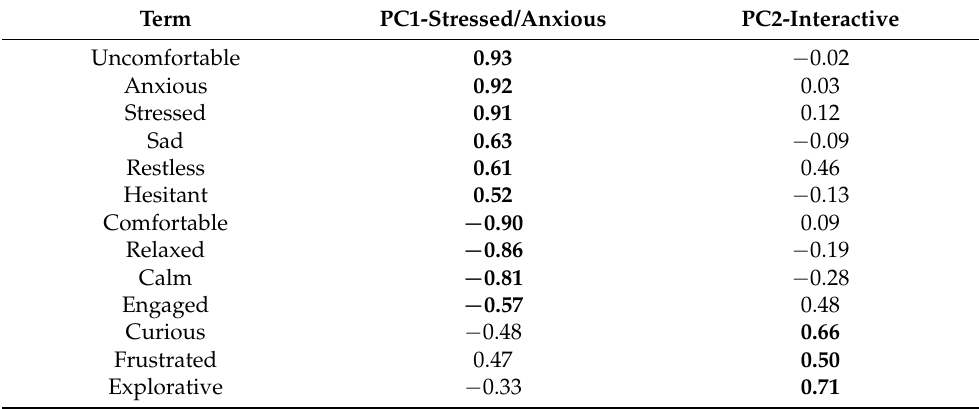
Table 4. Components extracted by the PCA of QBA scores. Loadings ≥ |0.50| are in